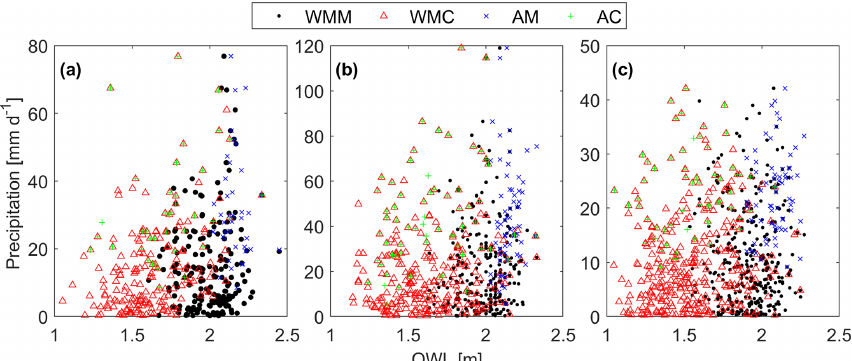
Figure 2. Data pairs for each sampling method. Annual maximum (AM; blue x), annual coinciding (AC; green + ), wet-season monthly maximum (WMM; black · ), and wet-season monthly coinciding (WMC; red (cid:52) ) at (a) Santa Monica, (b) Sunset, and (c) San